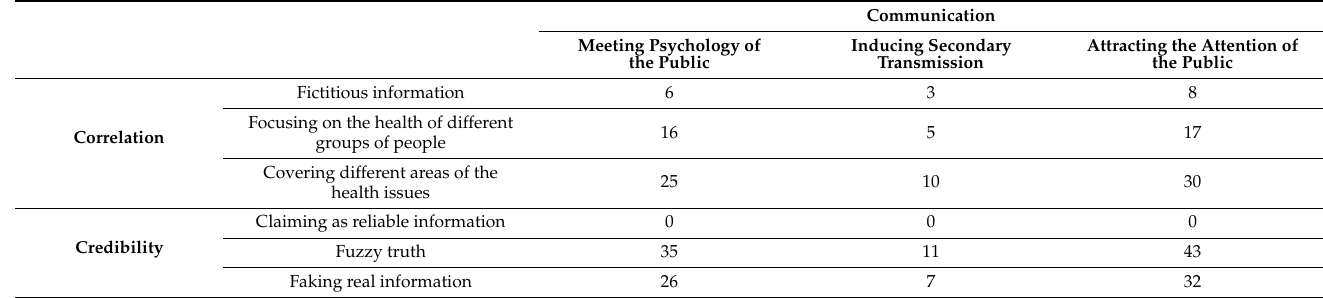
Table 4. Interaction of correlation, credibility, and communication based on 50 Internet health